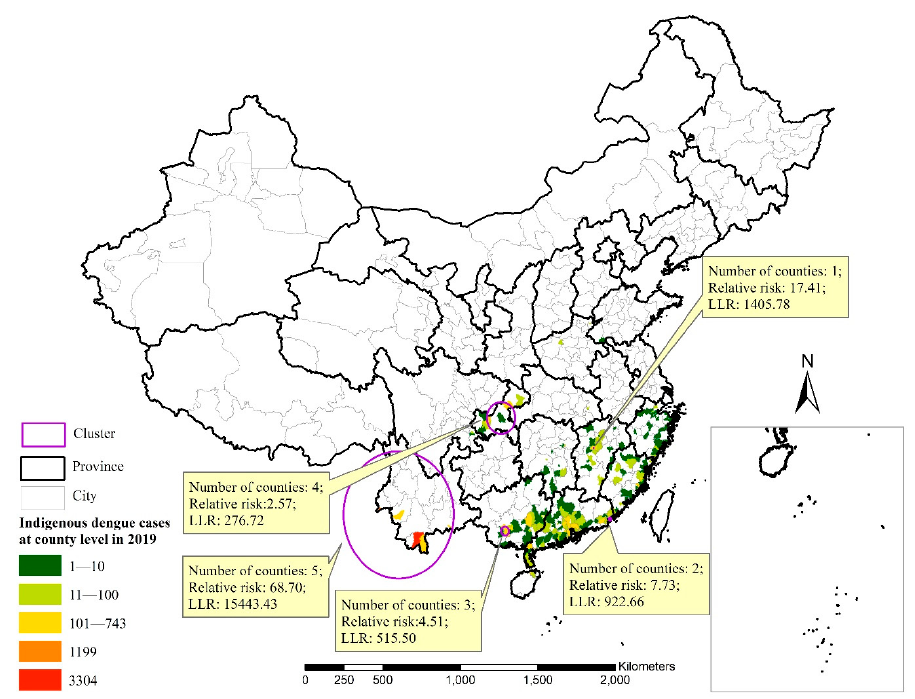
Figure 2. Space–time scan statistical analyses for indigenous dengue cases in mainland China in 2019.